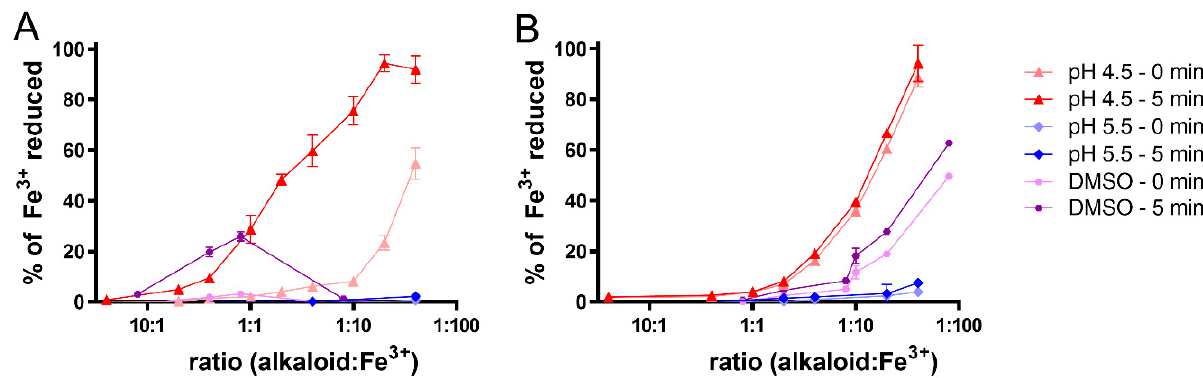
Figure 4. Iron-reduction activity determined immediately after measurement (time 0 min) and after 5 min. ( A ) scoulerine; ( B ) glaucine. No reduction was observed at pH 6.8 or